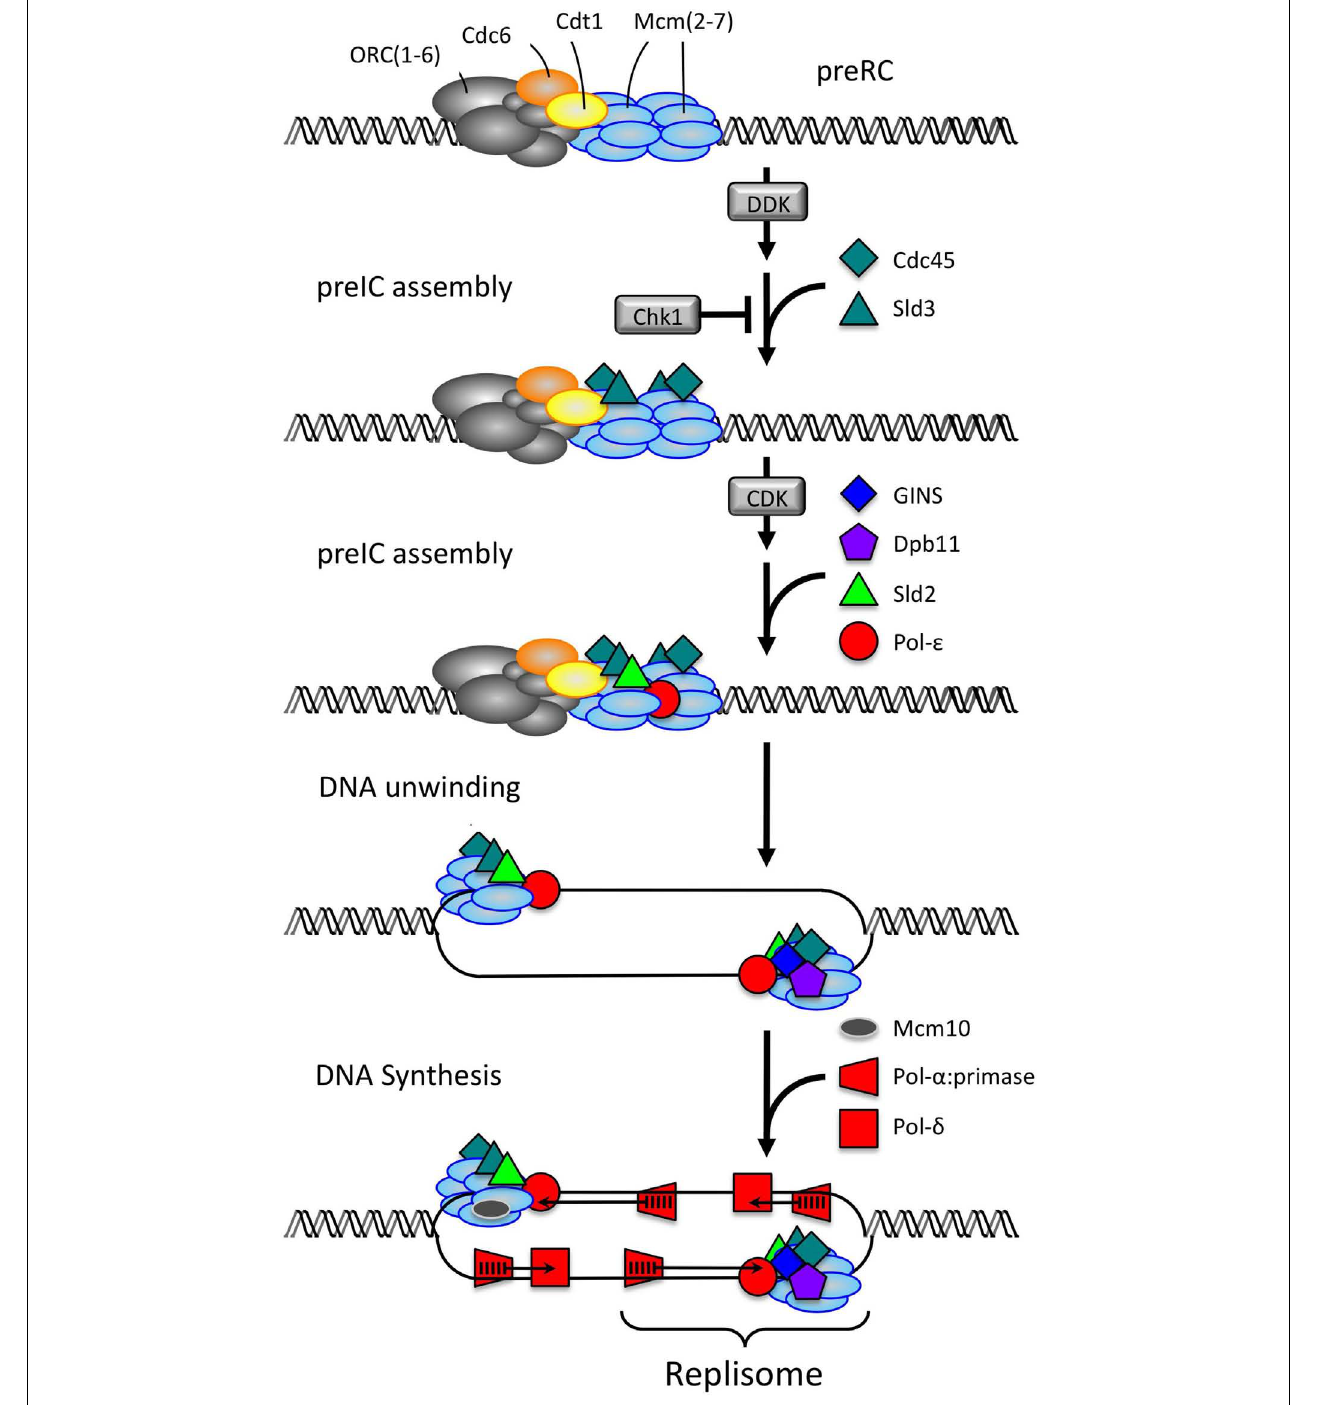
the MCM helicase, which in the presence of the single-strand DNA binding protein RPA, can unwind origin DNA.This event is followed by recruitment of Mcm10 (not shown).The formation of a Cdc45-MCM-GINS complex activates the helicase, which unwinds the DNA at the replication origin. Pol- α :primase and Pol- δ are loaded onto the unwound DNA to complete replisome assembly.Three genes have different names for the human analog of the indicate yeast protein:Treslin/Sld3, RecQ4/Sld2, and